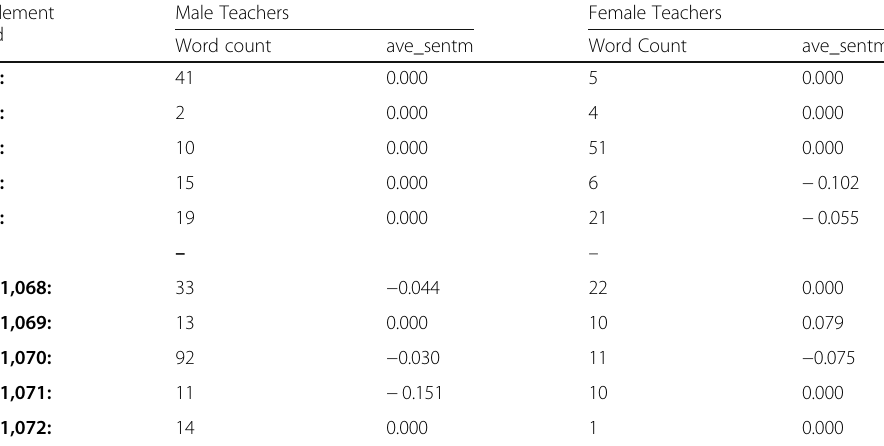
Table 1 Word count and average sentiment scores for individual student comments Element Male id